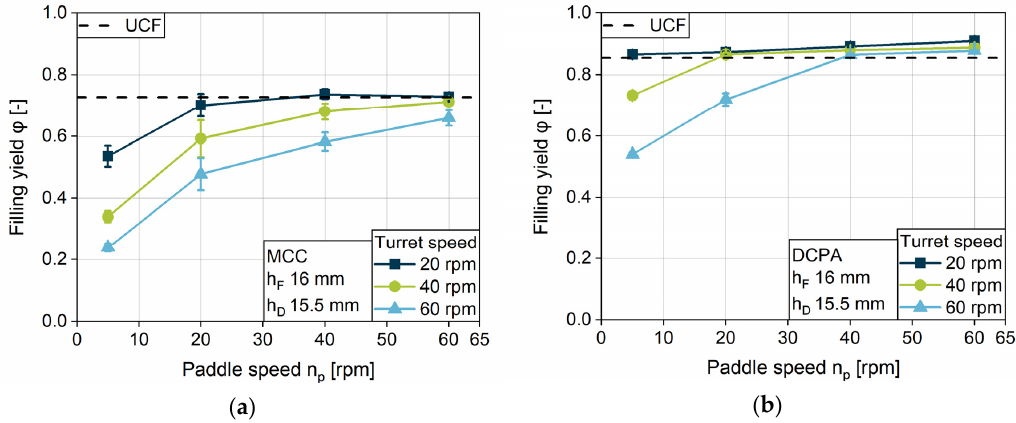
Figure 7. Impact of the paddle speed on the filling yield for ( a ) MCC and ( b ) DCPA with varying turret speed.